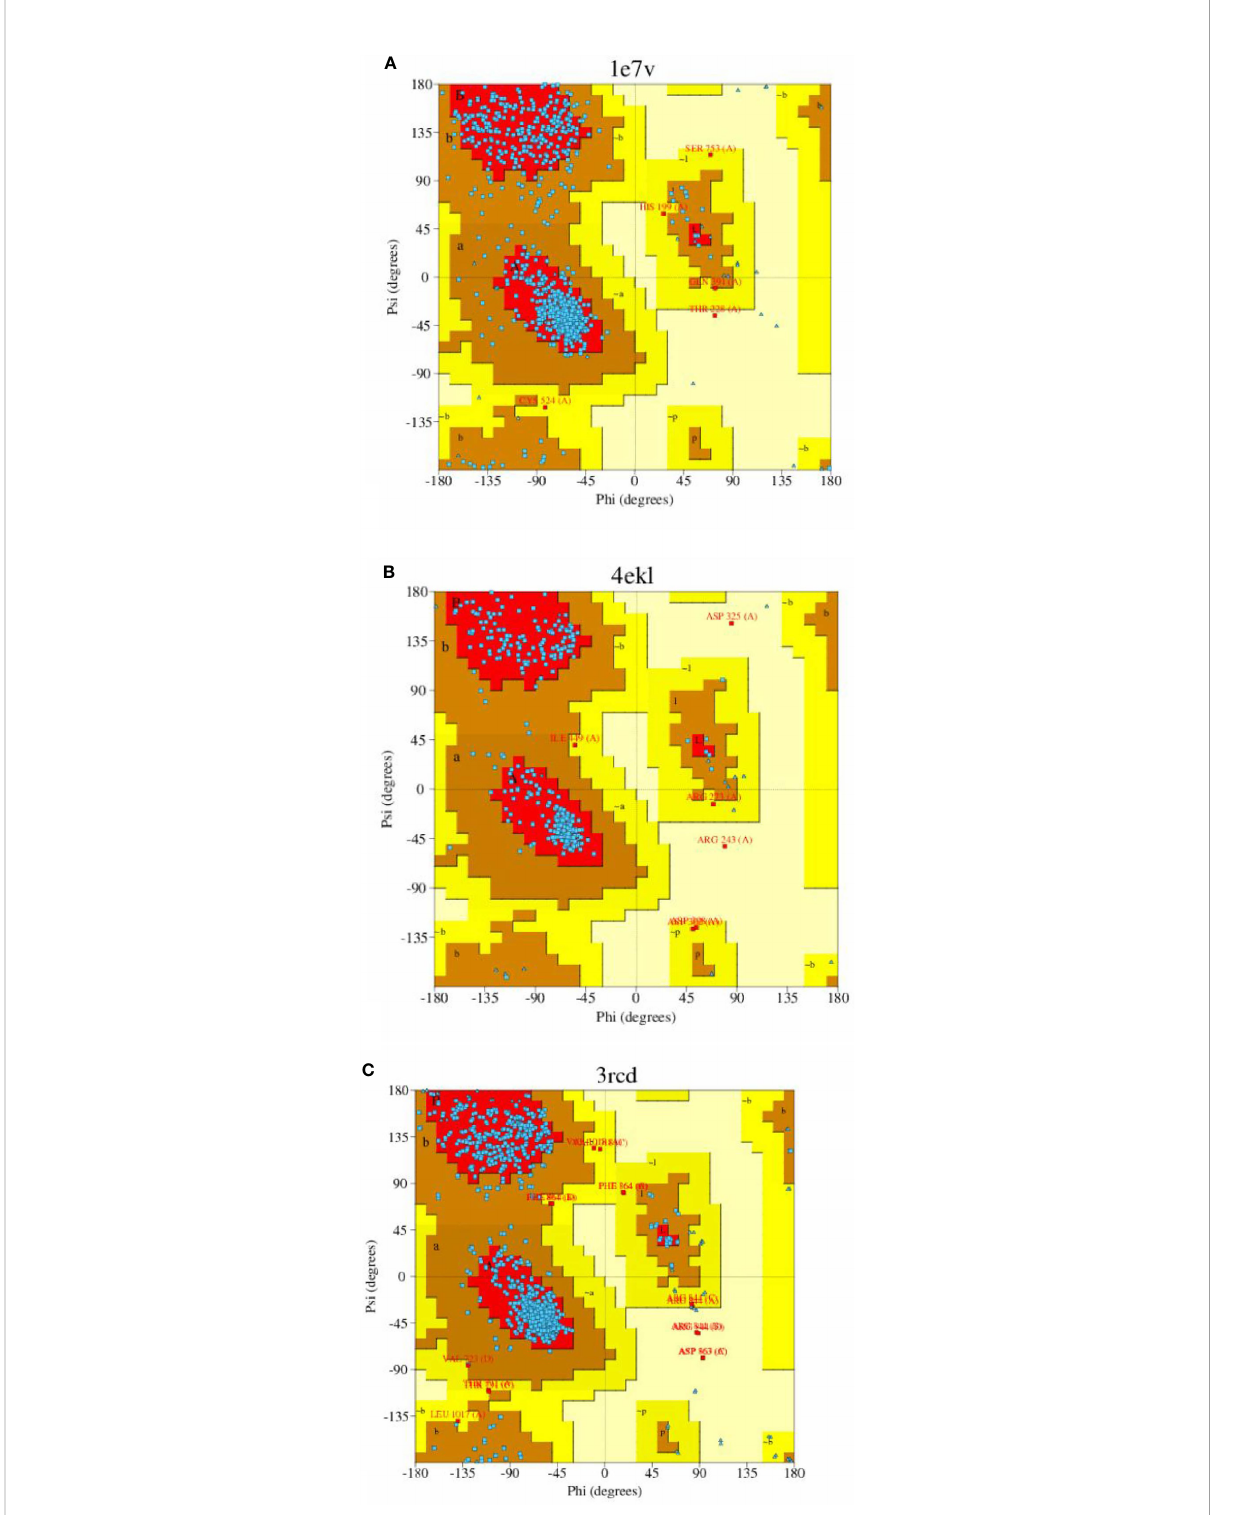
FIGURE 1 Stereo chemical quality of the target protein showing that the geometry of the protein target receptor corresponds to the highest likelihood conformation by torsional angles — phi and psi of the amino acid residues (Ramachandran plot) of target protein 1e7v (PIK) (A) , 4ekl (AKT) (B) , and 3rcd (HER2) (C)